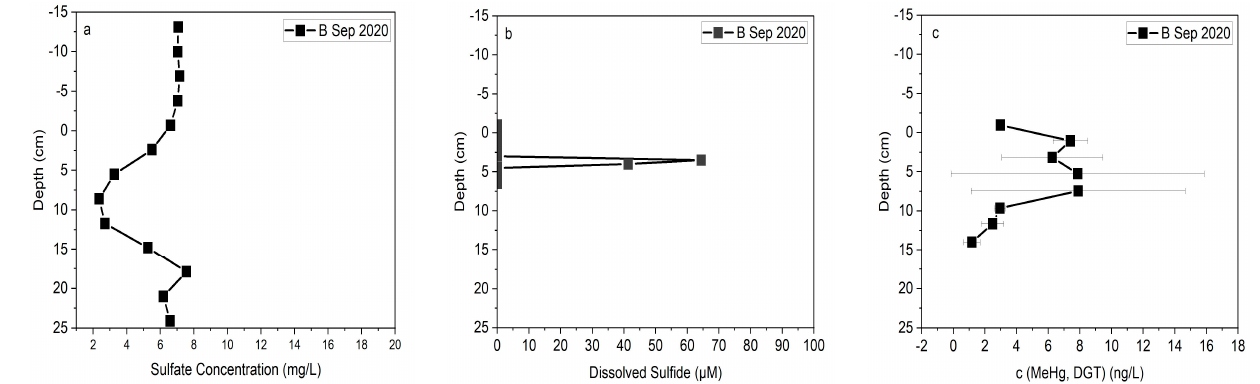
Figure 10. ( a ) Sulfate concentration, ( b ) dissolved sulfide concentration, and ( c ) MeHg concentration, profiles in L5 at Constitution Park (2020); on the y-axis, 0 represents the water/sediment interface and the negative numbers refer to distances above the interface (i.e., in the water column).